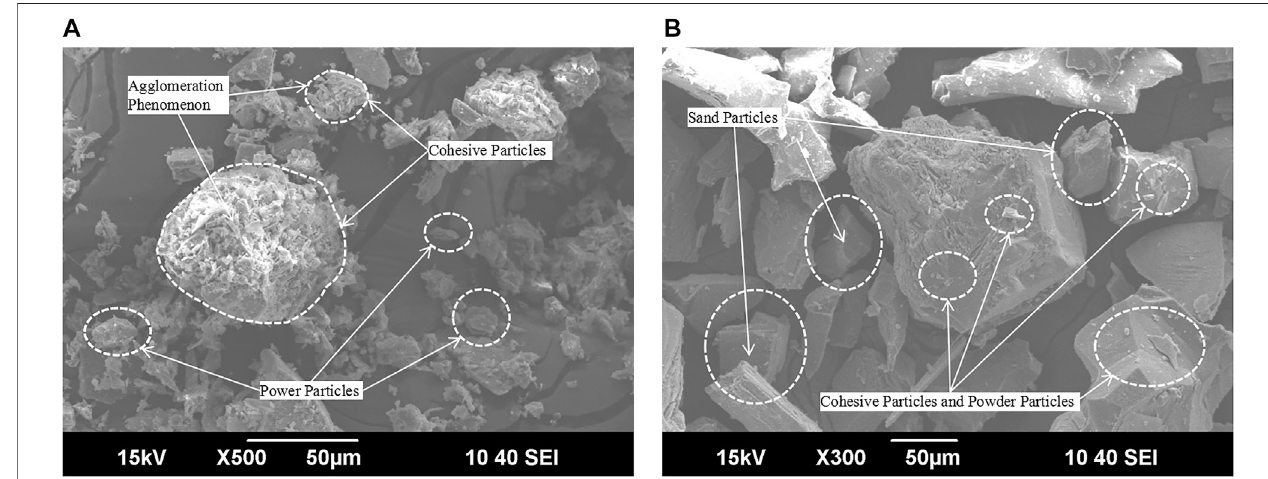
FIGURE 2 | SEM images of the tailings: (A) the ultra- fi ne tailings; (B) the classi fi ed tailings.